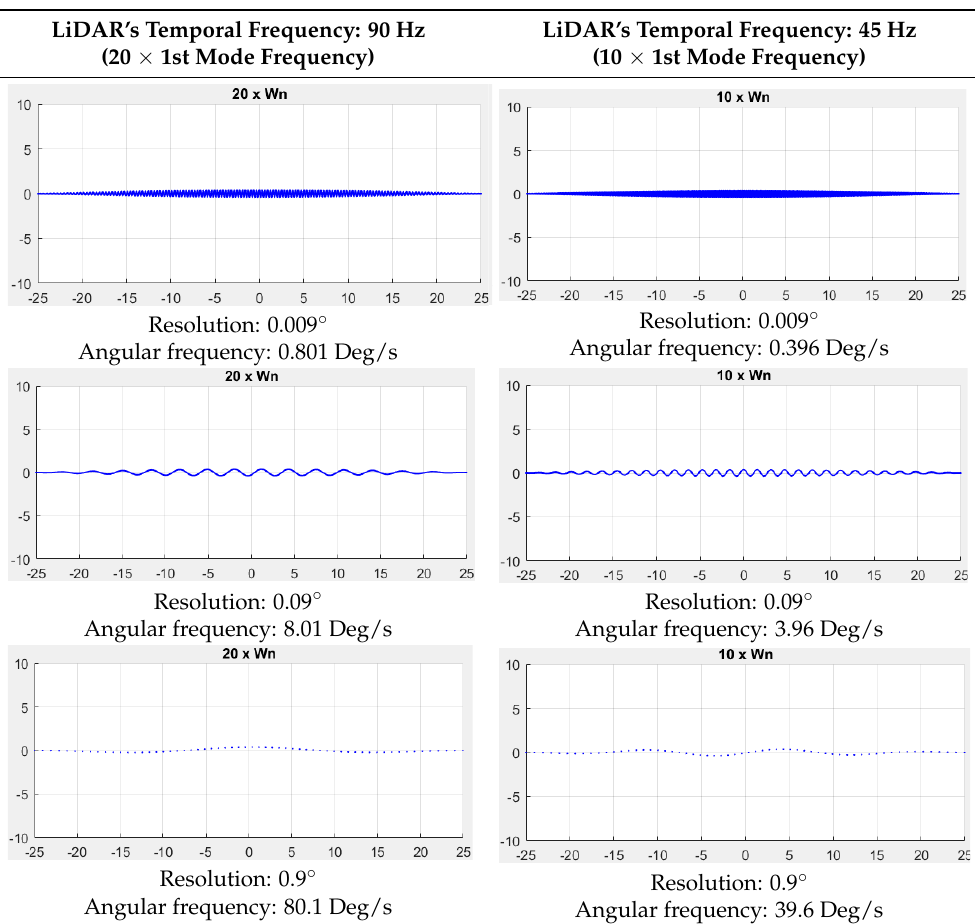
Table 6. Variation in the ripples pattern depending on the laser scanner configuration.